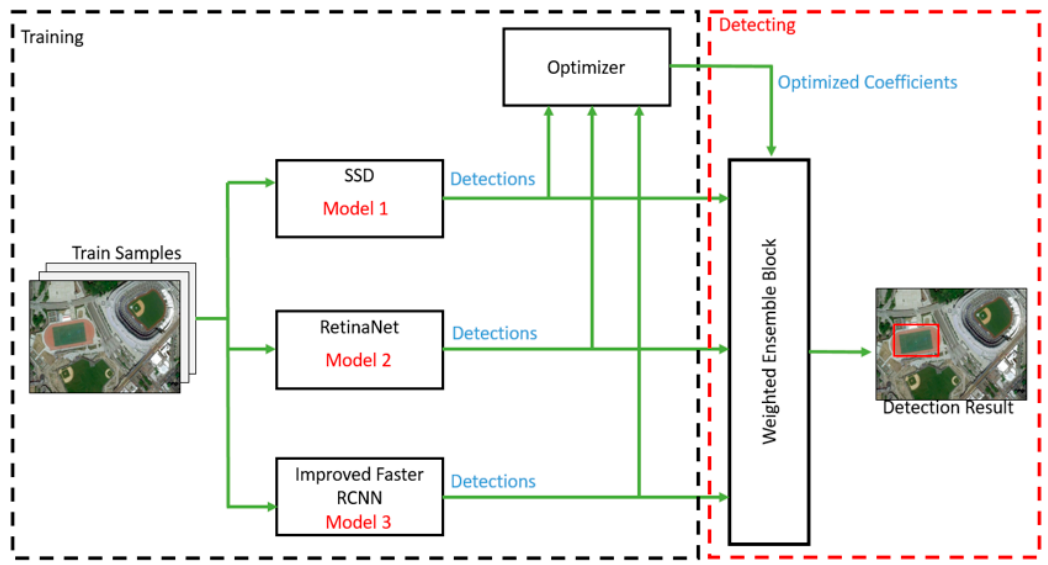
Figure 4. Block diagram of weighted ensemble object detection method with optimized coefficients .